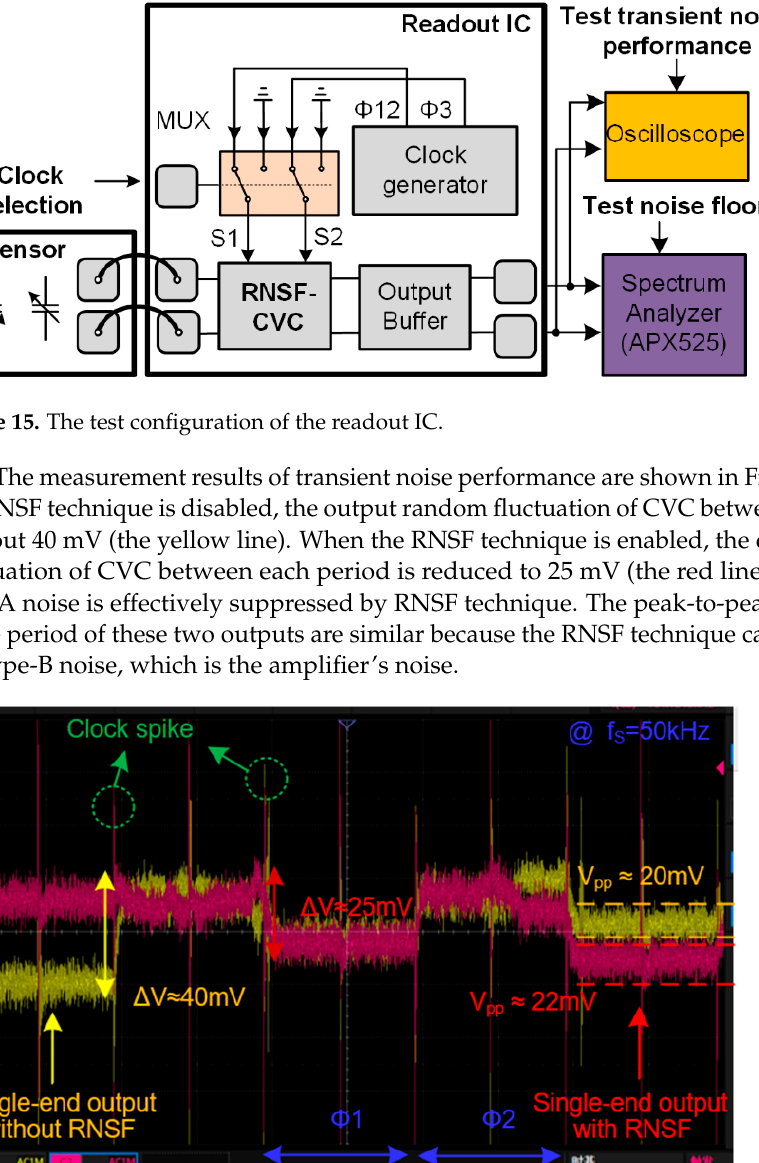
Figure 16. The measurement transient waveform of the output noise of the readout circuit with the RNSF technique and without the RNSF technique.